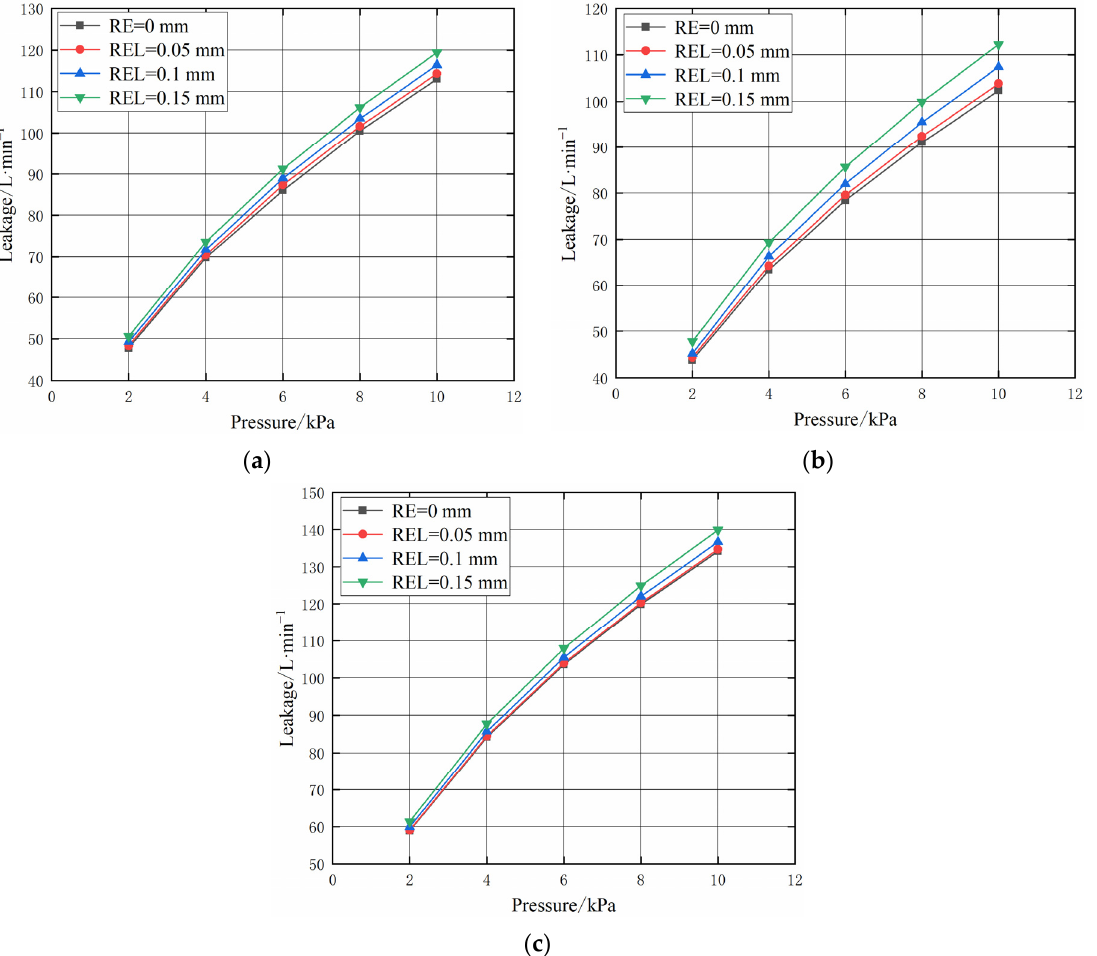
Figure 7. Leakage of three types of seals under different radial eccentricities. ( a ) Labyrinth seal; ( b ) honeycomb seal; ( c ) hybrid labyrinth–honeycomb seal.